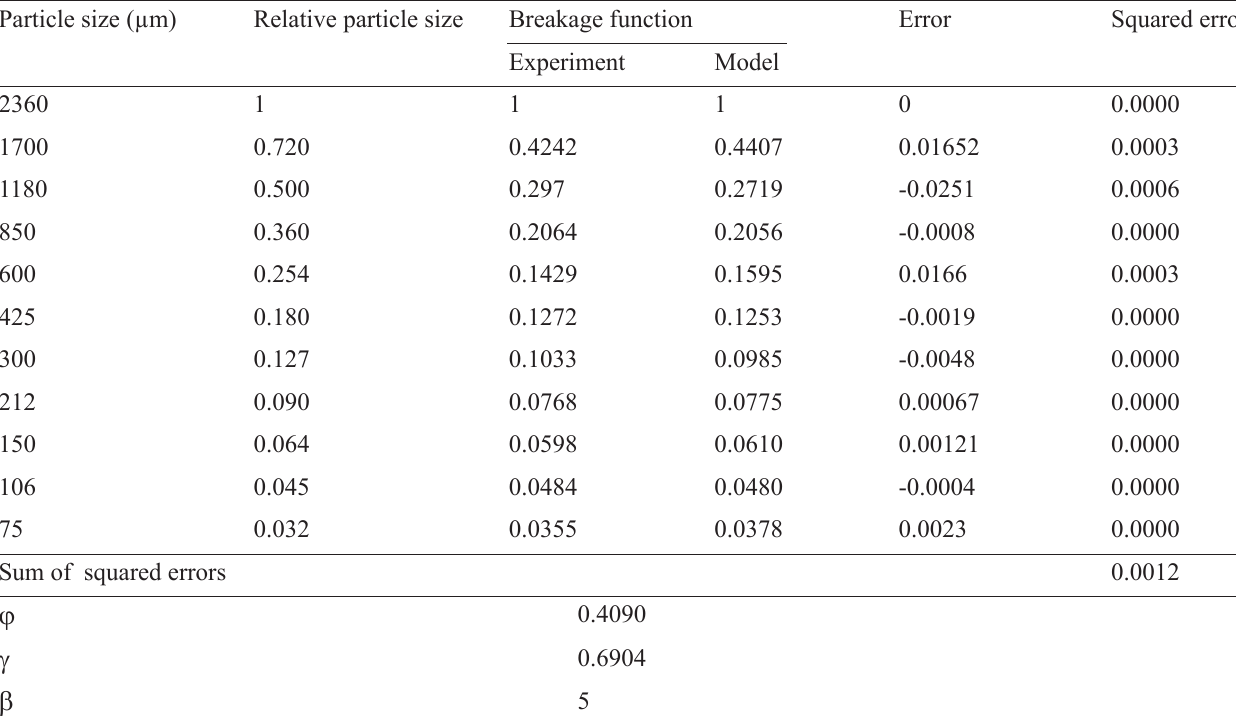
Table 3. The breakage function values for the microwave treated -3350+2360 µm